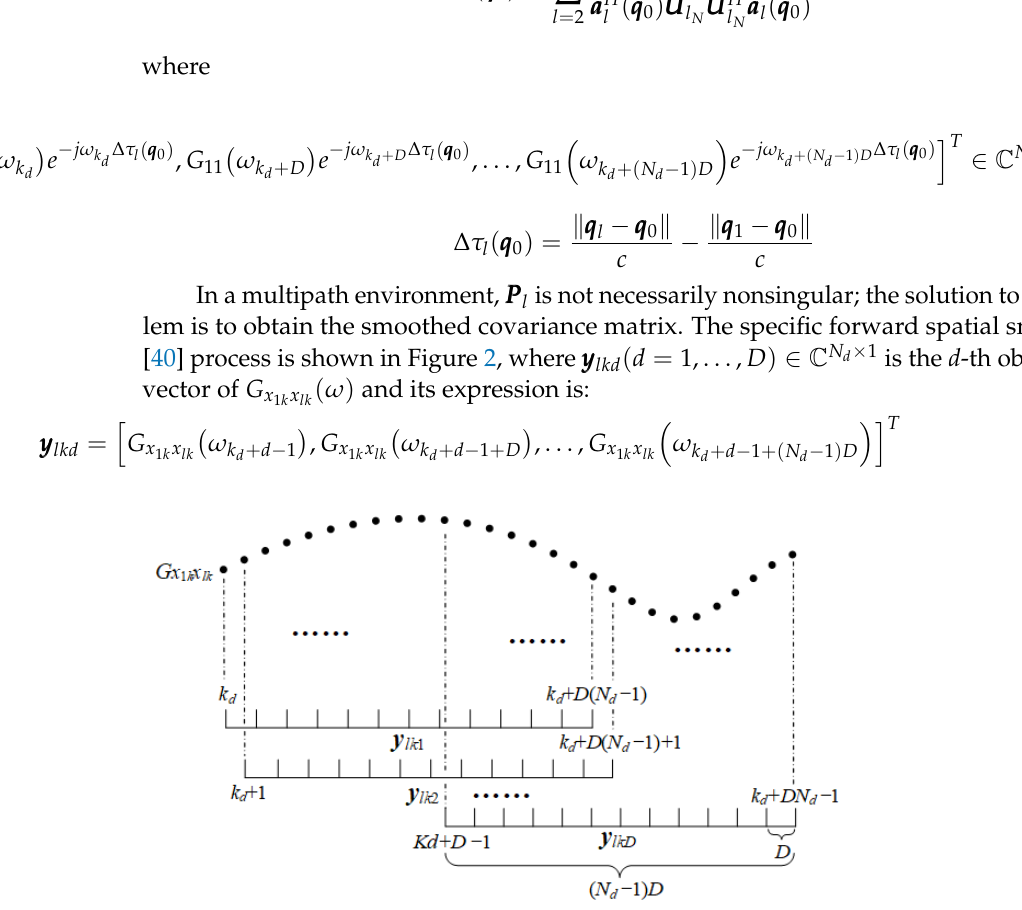
Figure 2. Schematic diagram of the forward spatial smoothing